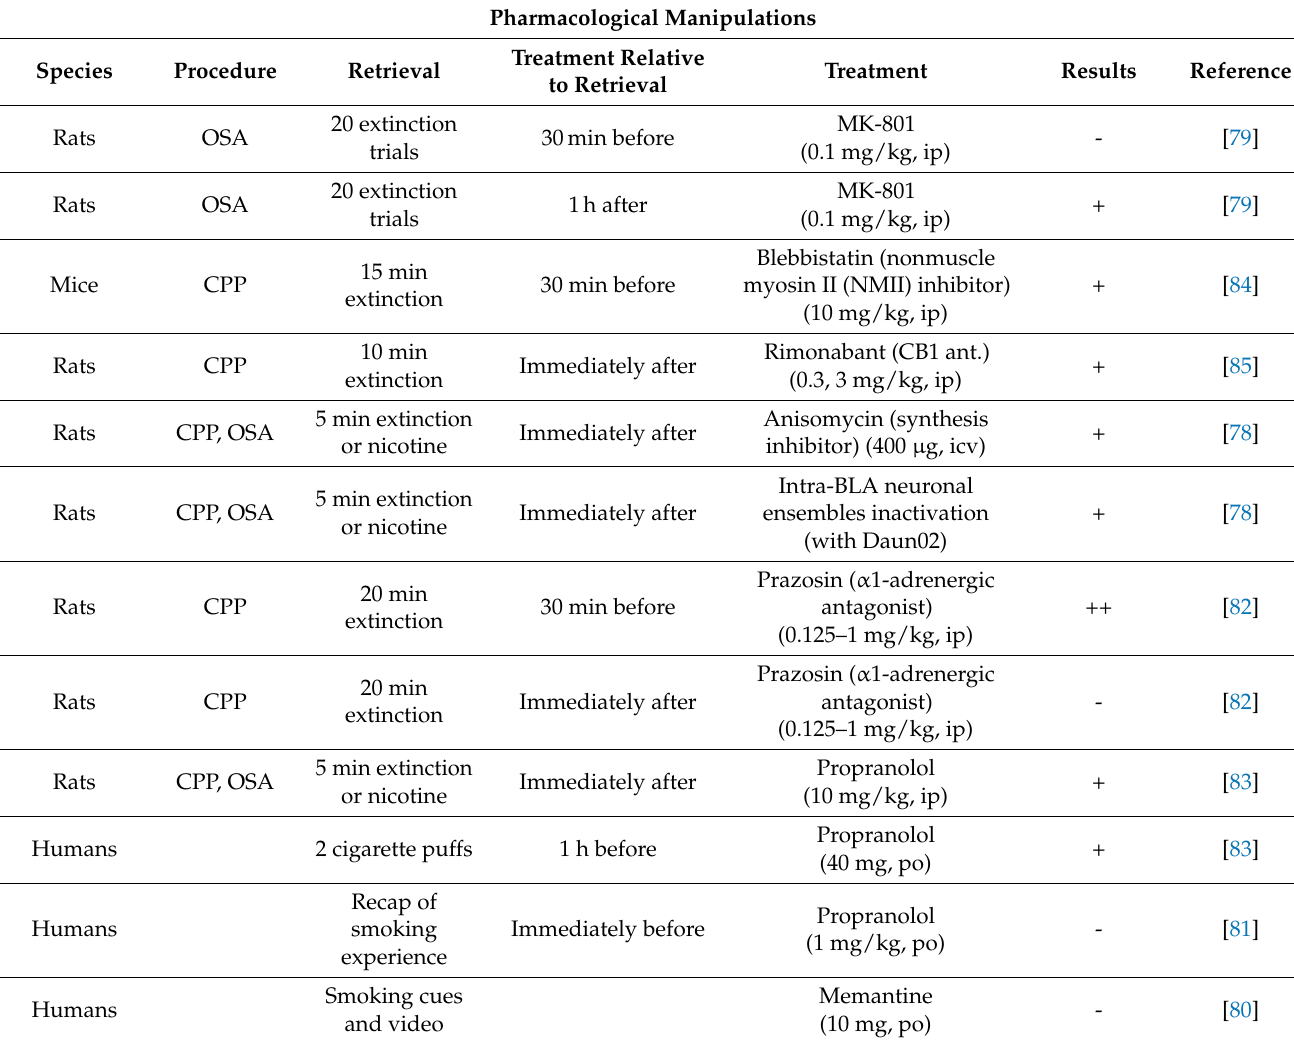
Table 2. Interference with nicotine-memory